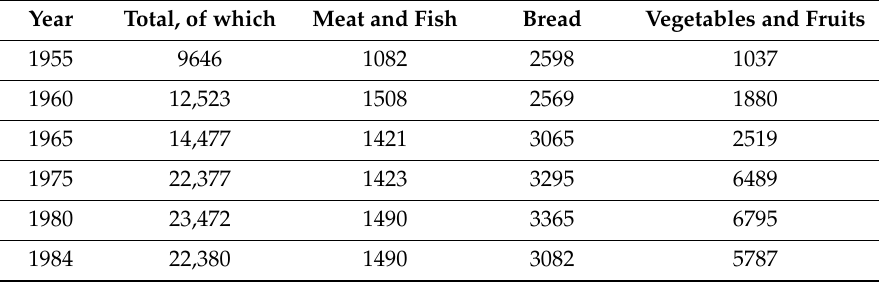
Table 3. Number of food stores and kiosks